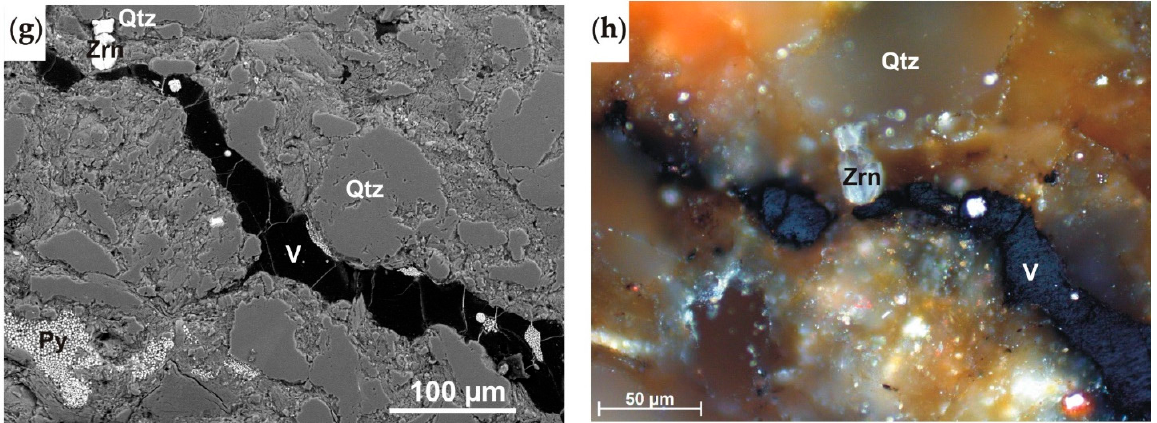
Figure 5. Back ‐ scattered electron BSE ( a , c , e , g ) and reflected light optical microscopy RLOM ( b , d , f , h ) images of samples collected in the northern part of the Jas ‐ Mos mining area. ( a ) Veins filled with (Mg, Fe)CO 3 ( Mg ‐ Sd) and quartz (Qtz) in vitrinite (V). Framboidal pyrite (Py) and accessory monazite (Mnz) are present. Right yellow rectangle is enlarged in ( b ), left rectangle in ( c ) and ( d ). ( b ) Quartzitic–carbonatic veinlets in vitrinite. ( c , d ) Secondary anatase (Ant) and halite (Hl) among quartz, muscovite (Ms) and clay minerals. ( e , f ) Framboidal pyrite partly replaced by hematite (Hem). ( g , h ) Acces ‐